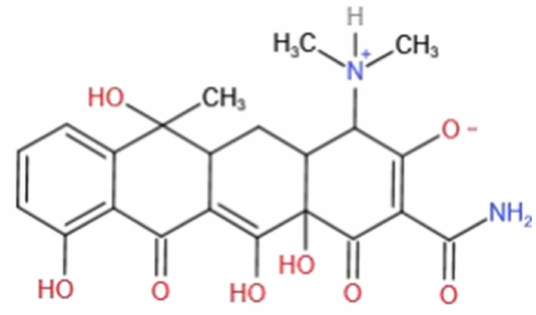
Figure 5. Molecular structural formula of